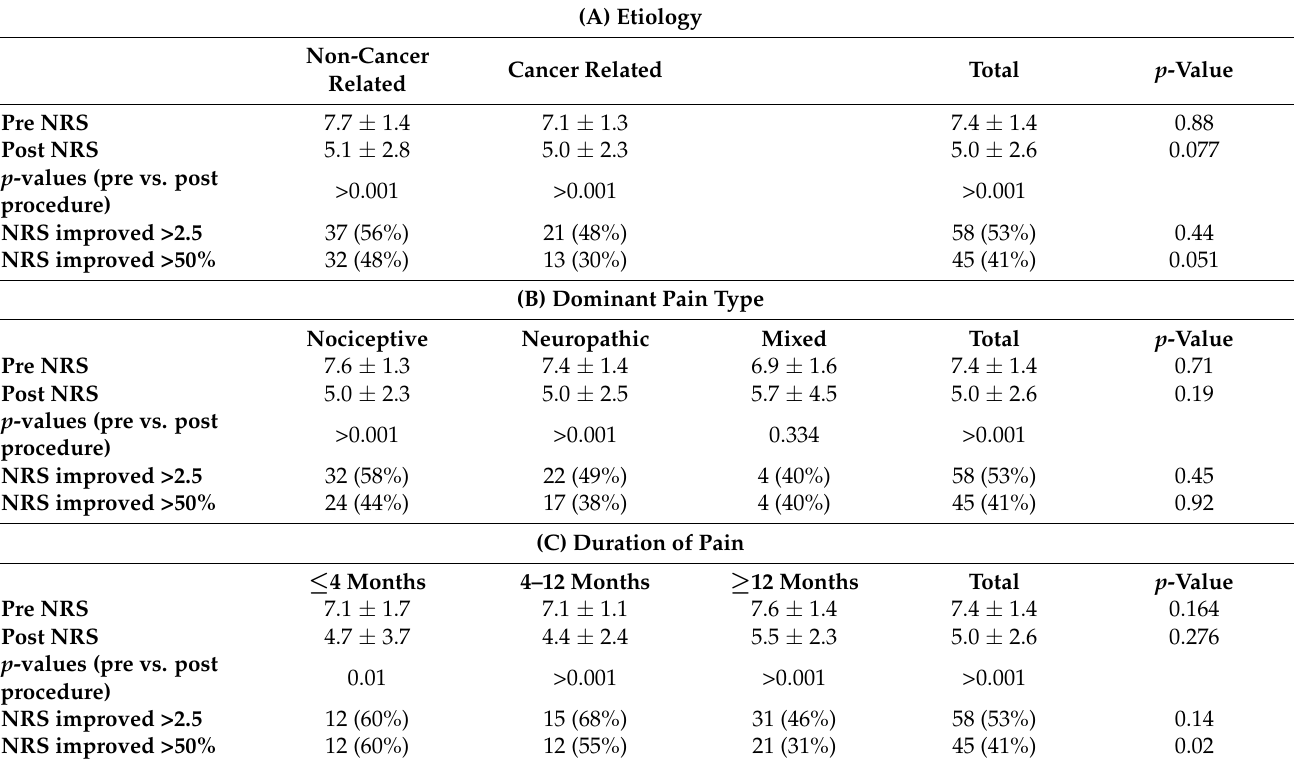
Table 3. Average pain